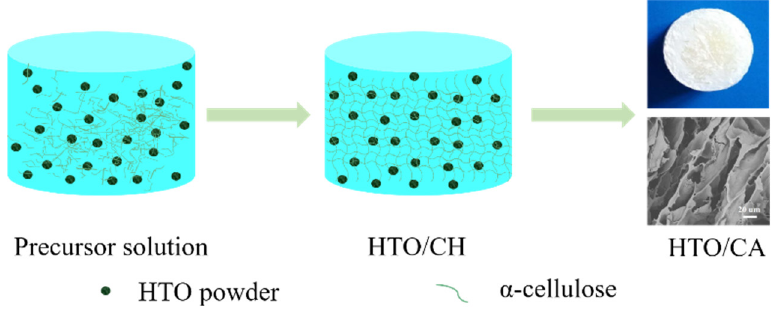
Figure 12. Schematic diagram of the preparation of HTO/CA.